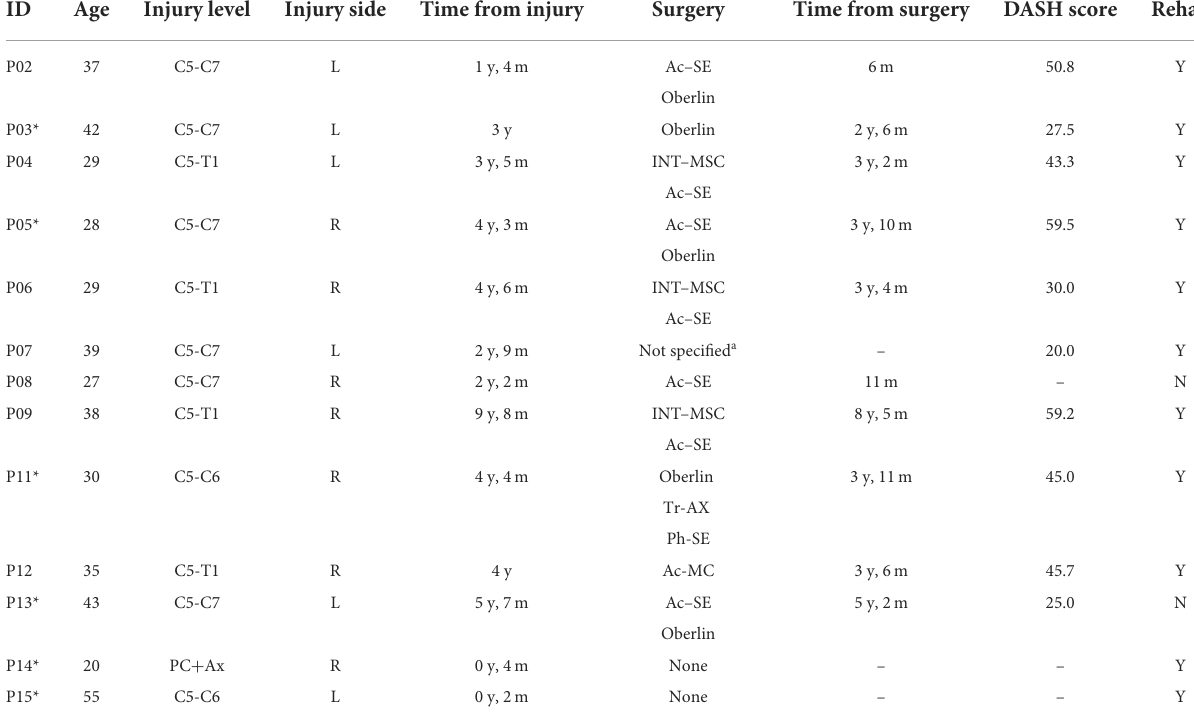
TABLE 1 TBPI individual